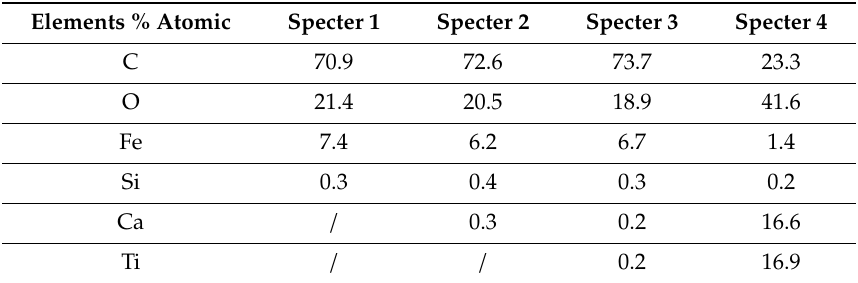
Table 2. The elementary composition of TWP at di ff erent positions by EDS analysis.